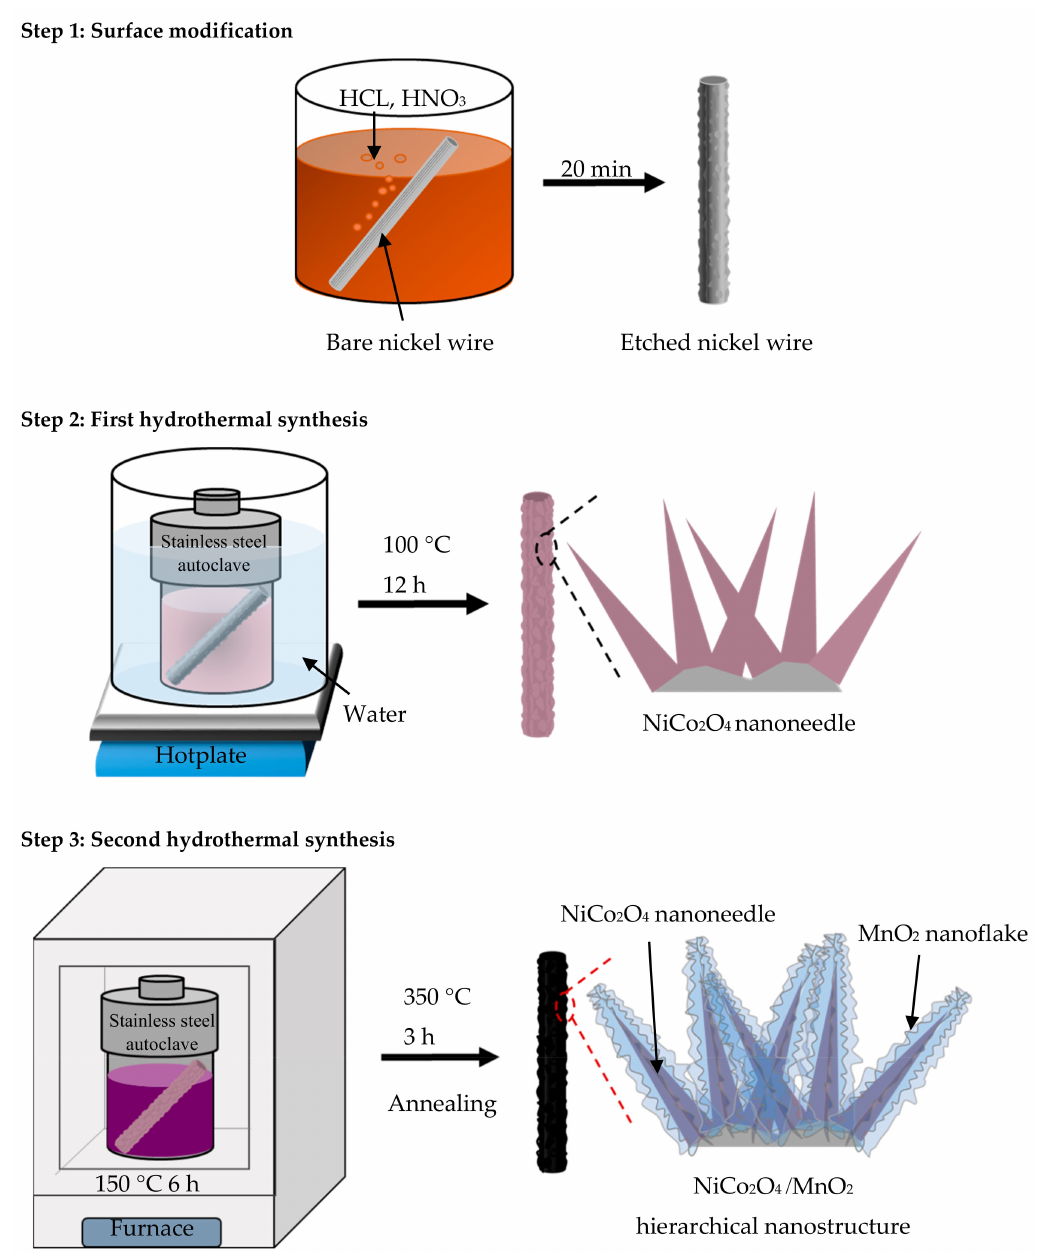
Figure 1. Synthesis of NiCo 2 O 4 / MnO 2 hierarchical nanostructures on etched Ni wire via a two-step hydrothermal